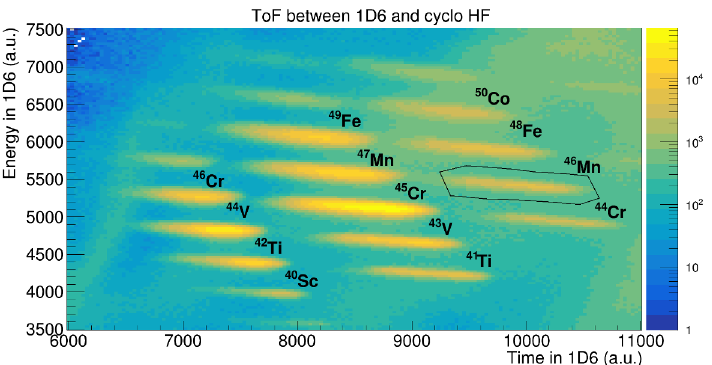
Figure 2. Energy loss in 1D6 detector vs time-of-flight 2D histogram used for the fragments identifica- tion of the nucleons implanted in the DSSSD